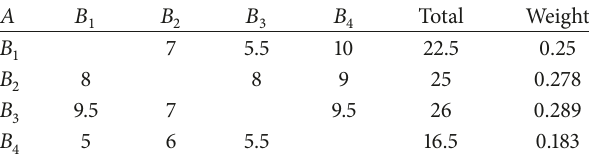
Table 13: Judgment matrix of 𝐵 3 − 𝐵 3𝑘 .